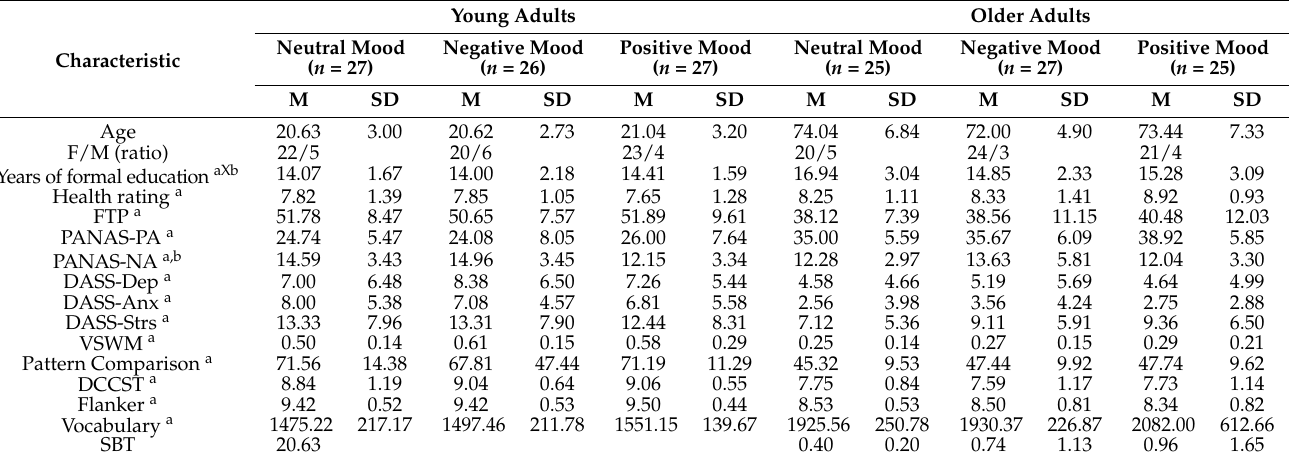
Table 3. Experiment 2 Participant Demographic Characteristics and Cognitive